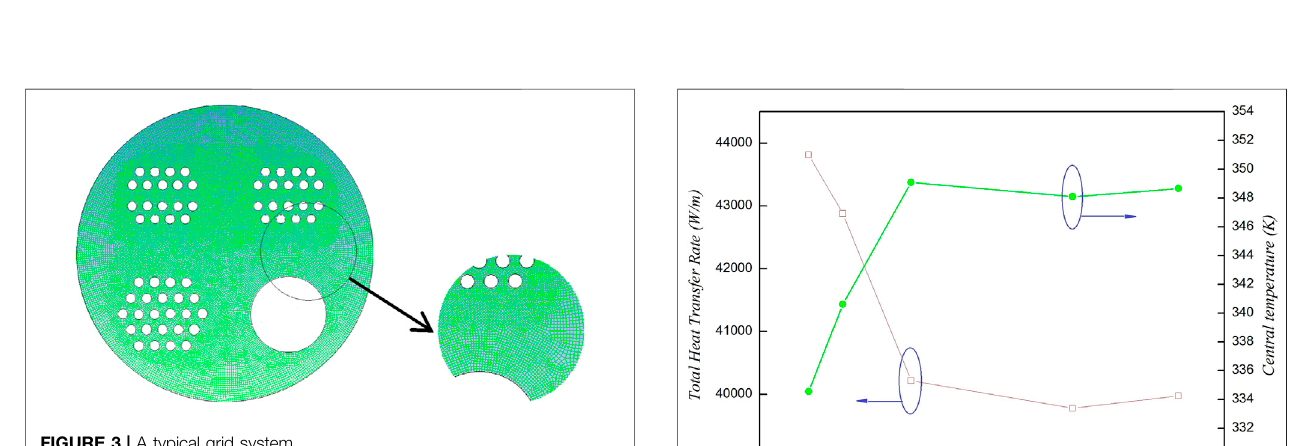
FIGURE 3 | A typical grid system.